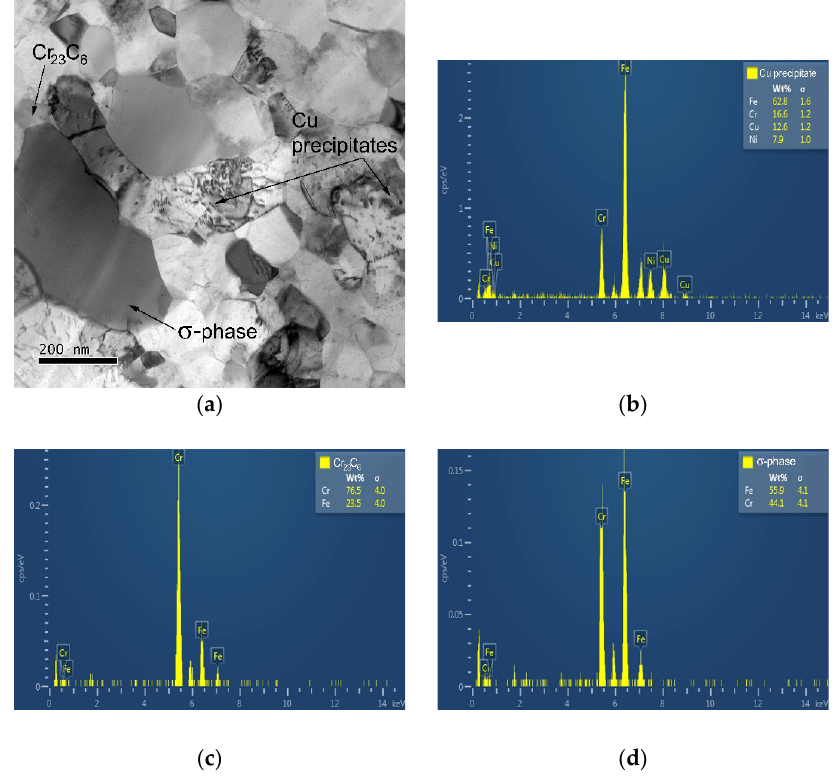
Figure 8. TEM micrographs for HPS-processed steel tested at ( a ) 600 ◦ C and 400 MPa, ( b ) chem- ical composition of Cu precipitate, ( c ) chemical composition of Cr 23 C 6 carbide and ( d ) chemical composition of σ